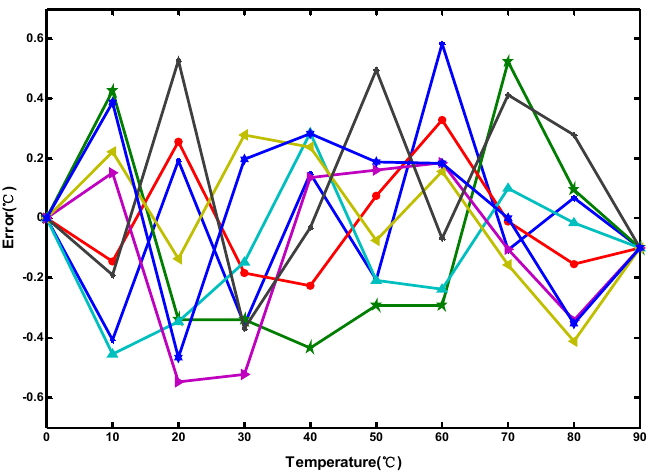
Figure 14. Measurement errors after two-point calibration for eight chips.